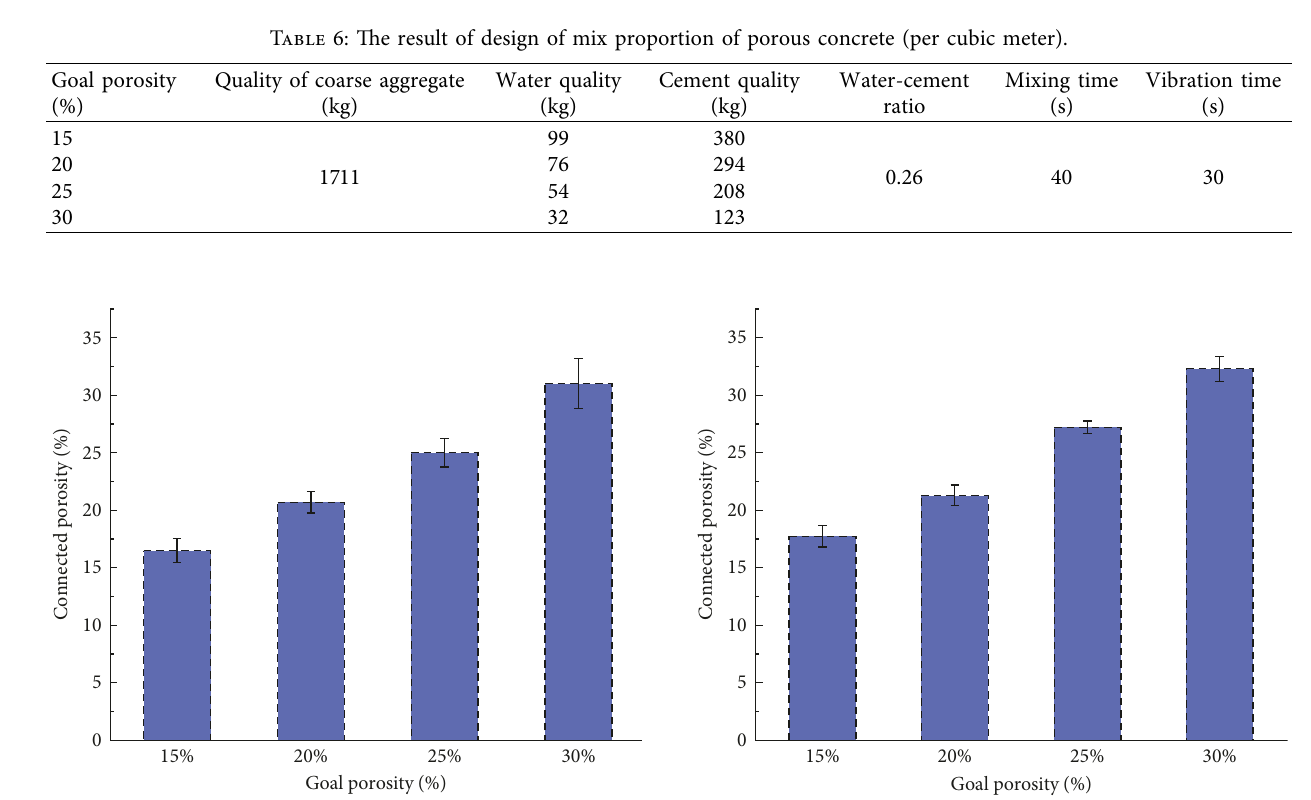
150mm 150mm (7d). Figure 7: Test results of 150 mm × ×